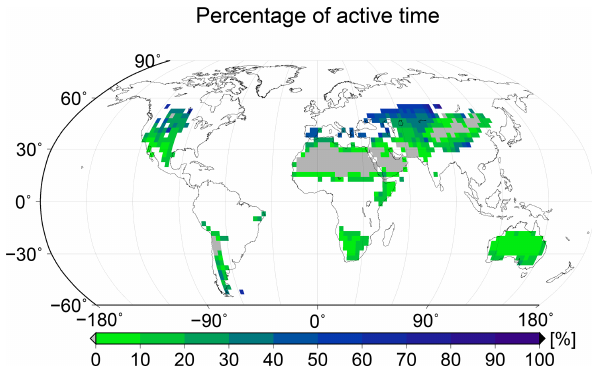
Figure 6. Global pattern of the percentage of time spent in a metabolically active state per year, simulated by LiBry. White ar- eas denote excluded regions, while grey areas correspond to regions where no simulated strategies are able to